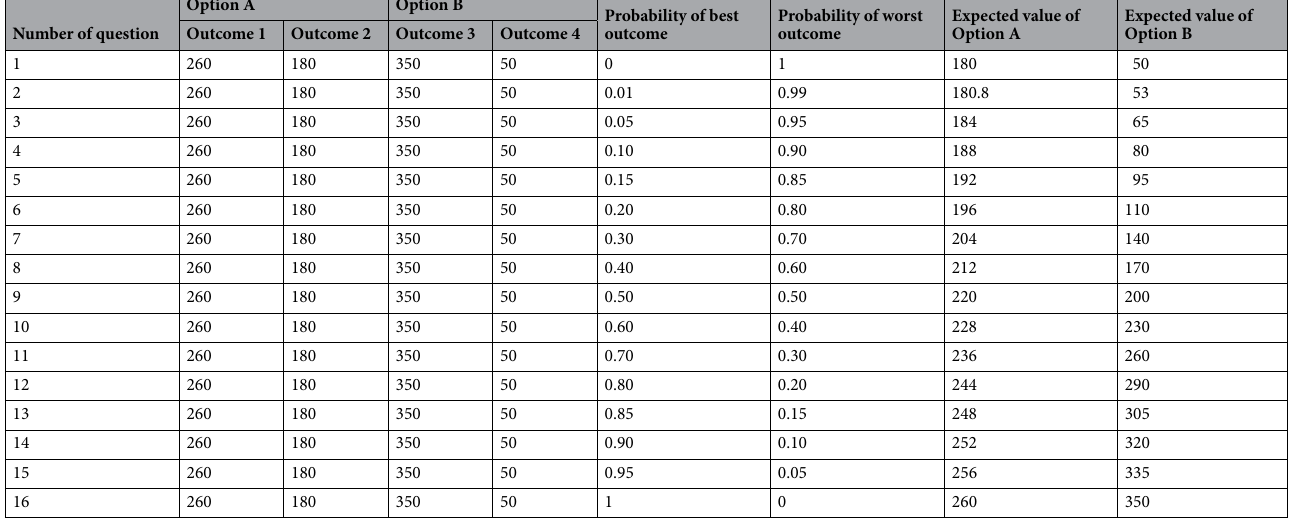
Table 1. Example of the MPL used in the experimental task. Expected values were not shown on the